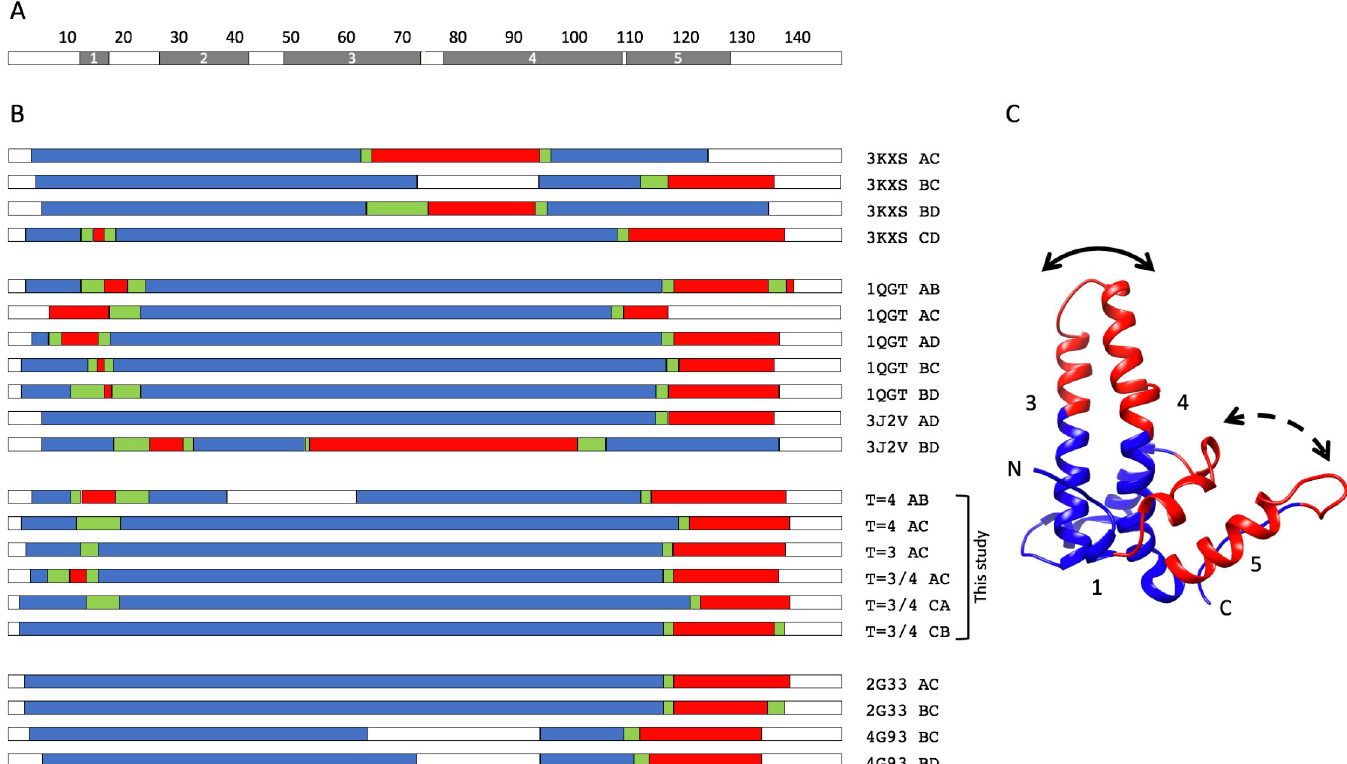
Fig 4. Dynamic domain analysis with DynDom . (A) Domain structure of HBcAg, residues 1–149, with helices shown in Grey. (B) Domain assignment by DynDom . Blue and Red indicate regions classed as domains, Green indicates residues classed as hinges, Clear regions are undefined. All structures are capsids except 3KXS, all are apo except 2G33 and 4G93, and all are T = 4 except where noted. T = 3/4 denotes comparison of chains between the T = 3 and T = 4 capsids described here, in the order given. Of the 72 chain combinations tested (S4 Table), only these 21 were classed as “dynamic” by DynDom . (C) Ribbon diagram of a monomer colored as an approximate composite of the domains shown in (B). In DynDom animations of chain pairs from soluble dimers the apical region of helices 3 and 4 generally moves relative to the rest of the molecule (solid arrow), whereas, in chain pairs from capsids, helix 5 and the region between helices 1 and 2 move in concert with one another (dashed arrow). This is reminiscent of the “chassis” and “fulcrum” model proposed previously. In soluble dimers (3KXS) and liganded structures (2G33 and 4G93) the “fulcrum” region is generally not detected. Residues beyond 140 are never classed as being in a domain, similar to the observation that constructs truncated before this residue cannot assemble in vitro